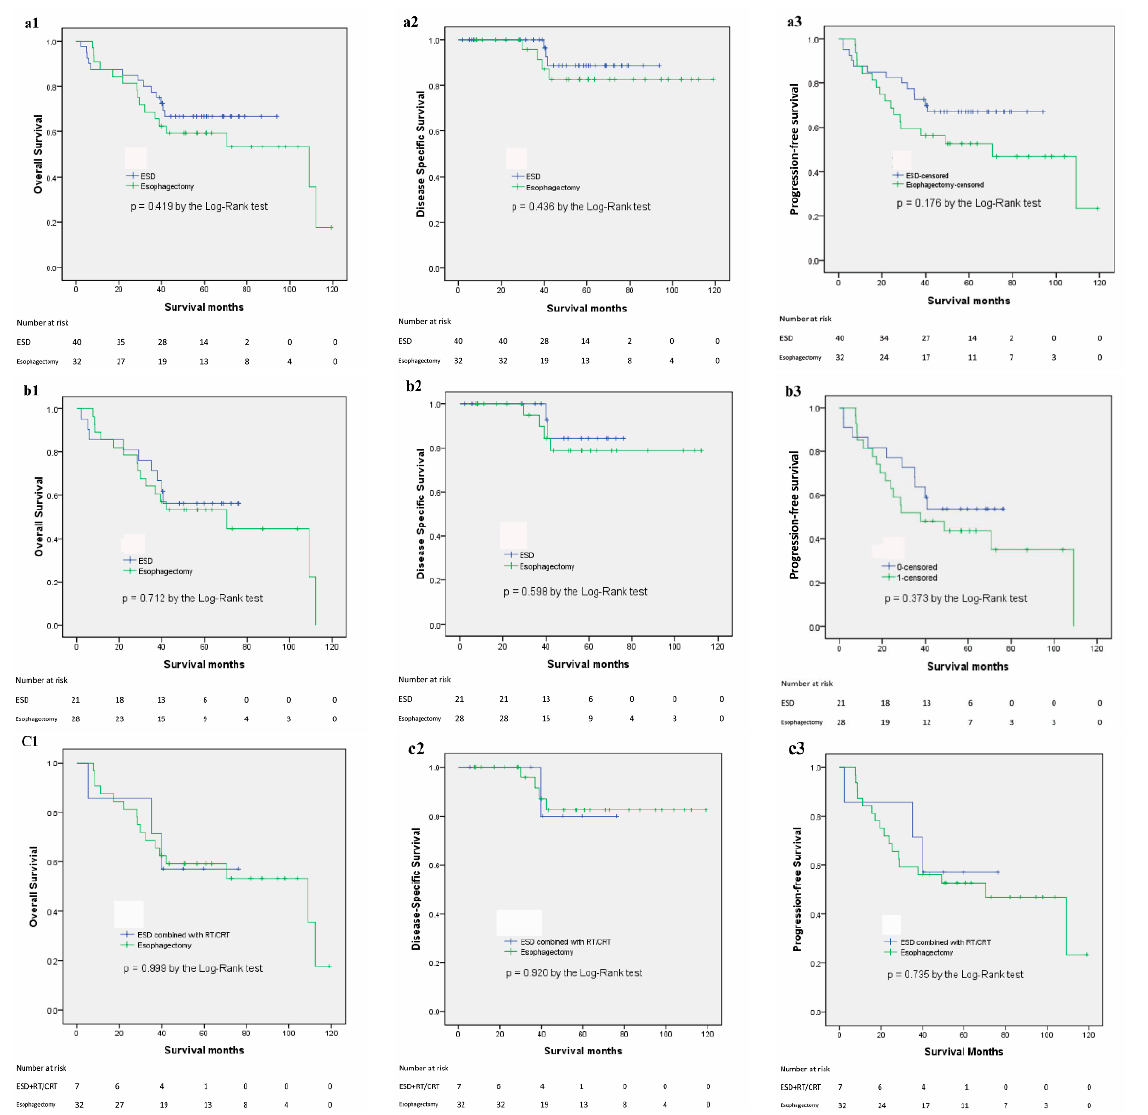
Figure 2. Kaplan–Meier survival curves for the endoscopic submucosal dissection and esophagec- tomy groups. ( a ): all study population; ( a1 ): overall survival; ( a2 ): disease-specific survival; ( a3 ): progression-free survival. ( b ): a subgroup of patients with pT1b diseases; ( b1 ): overall survival; ( b2 ): disease-specific survival; ( b3 ): progression-free survival. ( c ): endoscopic submucosal dissection combined with radiotherapy/chemoradiotherapy versus esophagectomy: ( c1 ): overall survival; ( c2 ): disease-specific survival; ( c3 ): progression-free survival. Abbreviations: ESD: endoscopic submuco- sal dissection; RT: radiotherapy; CRT: chemoradiotherapy.